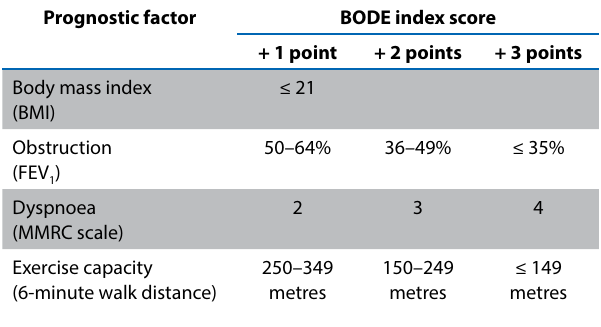
Table 6. BODE index score to predict mortality in COPD